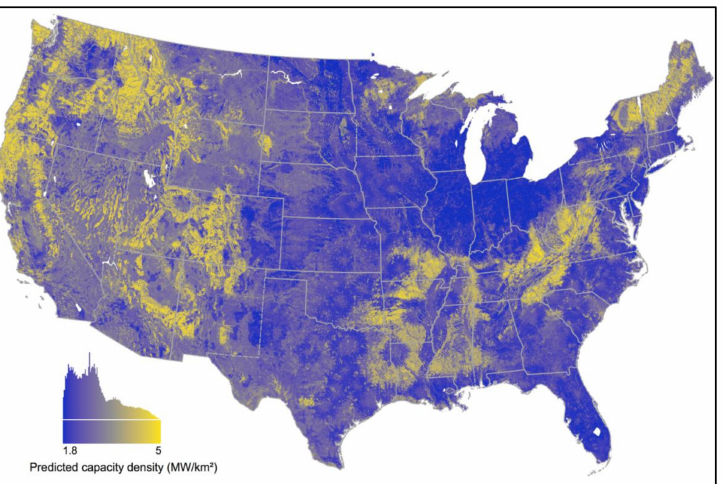
Figure 7. Map of predicted capacity density for CONUS. Areal capacity density represents potential nameplate capacity installation per unit ground area and is measured in MW/km 2 . Predictions are made at a 2 km × 2 km spatial resolution based on the Wind Integration National Dataset (WIND) Toolkit wind resource dataset [56]. As described in previous sections, variations in capacity density reflect that wind farm land requirements are driven by multiple variables and that these phenomena contribute to substantial differences in both observed and predicted capacity densities across the country. Information on capacity density is needed to quantify wind deployment potential and is a key input into technical potential analysis and other downstream assessments (e.g., supply curve modeling). The histogram shows the distribution of predicted capacity density at the national